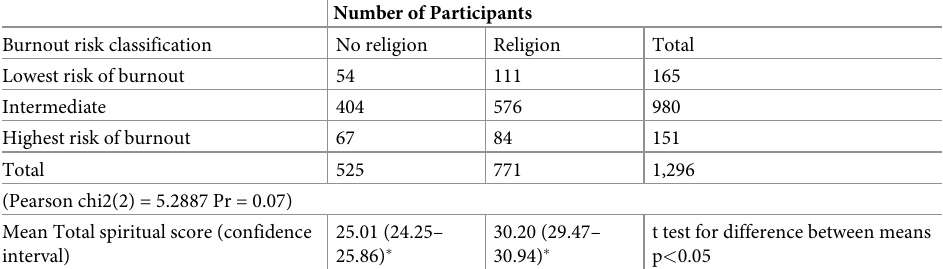
Table 3. Burnout and spiritual scores compared for those who identified as having a religion, compared with those stating ‘no religion’ or atheist.